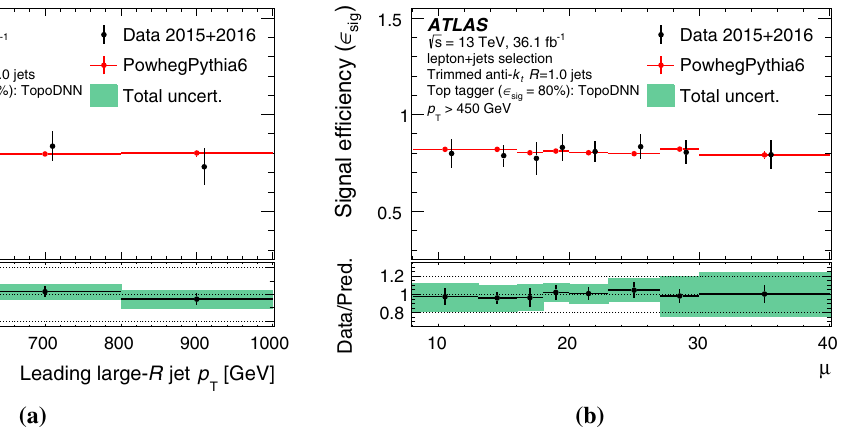
Fig. 21 The signal efficiency on contained top-quark jets for the TopoDNN top-quark tagger as a function of the large- R jet p T ( a ) and the average number of interactions per bunch crossing μ ( b ) in data and simulation. Statistical uncertainties of the signal efficiency measure- ment in data and simulation are shown as error bars in the top panel. In the bottom panel, the ratio of the measured signal efficiency in data to